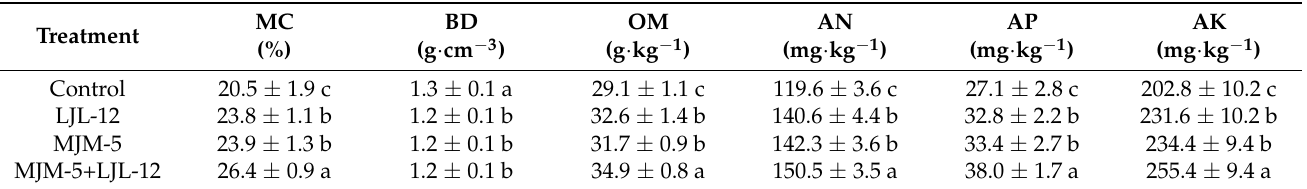
Table 2. Physical and chemical properties of the soil in the alfalfa rhizosphere under Control, LJL-12, MJM-5, and MJM-5+LJL-12 treatments.